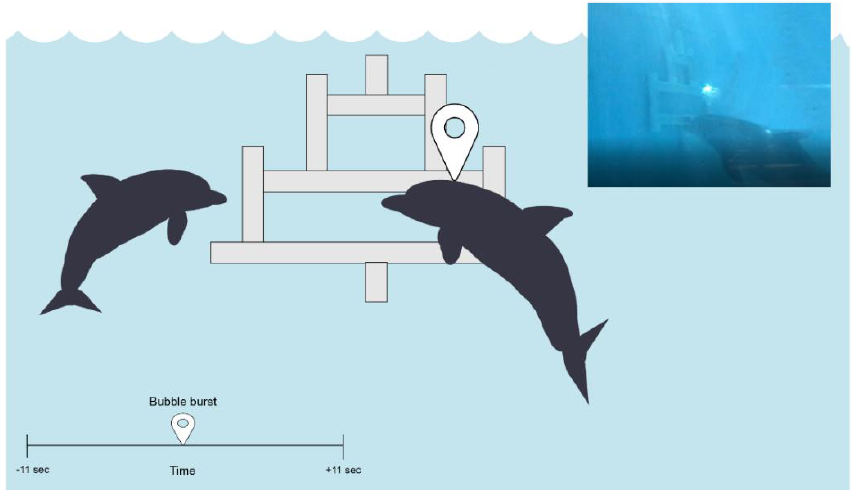
Figure 1. A bottlenose dolphin engaged with the underwater task, and another dolphin spectating within one body length (approximately 2.5 m). Behaviour sequences within 11 s of a burst were analysed using THEME, and sequences 11 s duration were analysed using a GLM. Photograph (inset) shows real footage from underwater window.